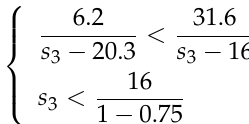
Figure 13. Profile of track surface. The curve A 2 B 2 C 2 D 2 in Figure 13 is the profile of the track surface. The profile curve is divided into three sections, all of which are circular arc designs. Section A 2 B 2 is an open transition area, as is B 2 C 2 , and C 2 D 2 is a closed transition area. According to the analysis of the idling process that does not hold the shrimp, during the movement of the clamping unit from point A 2 to point B 2 , the holding plate gradually changes from fully closed to fully open. During the movement of the clamping unit from point B 2 to point C 2 , the clamping plate is always open. During the movement of the clamping unit from point C 2 to point D 2 , the clamping plate is gradually closed. In other positions, the clamping plate is closed. When the shrimp is clamped, the A 2 B 2 section is mainly the shedding of the shrimp shell. The clamping plate is opened so that the clamping force disappears, and the shrimp shell falls under the action of gravity. Section B 2 C 2 is the area where the shrimp falls into the clamping mechanism. The opening of the clamping plate facilitates the entry of the shrimp into the clamping station. The C 2 D 2 segment clamping plate gradually exerts pressure on the shrimp to achieve stable clamping. According to the analysis, the profile model of the designed track surface is as fol- lows: